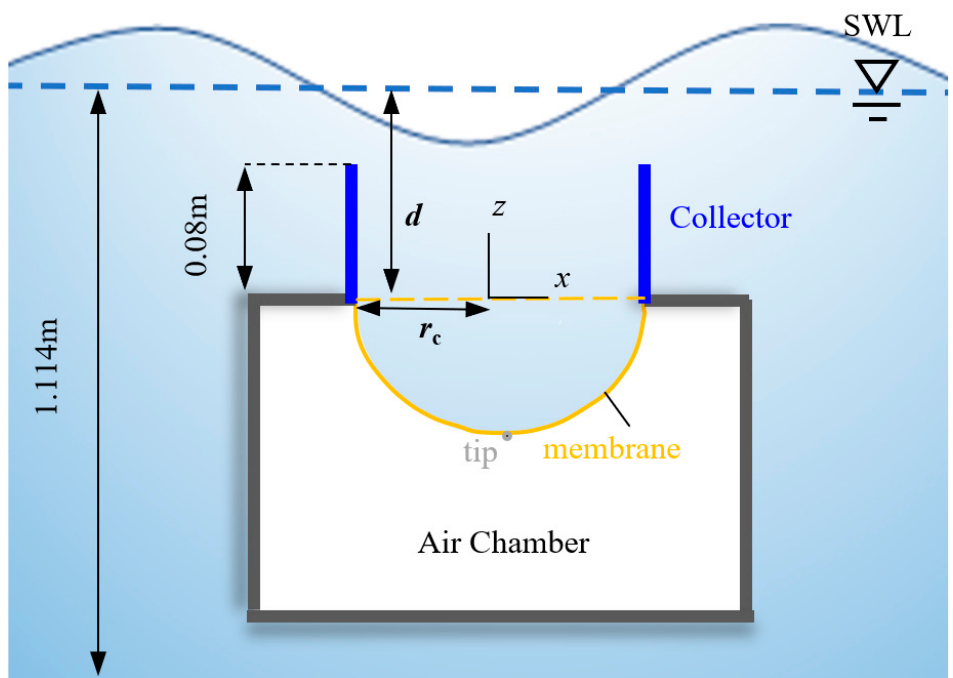
Figure 2. Sketch of the fWEC model. The plates in blue are given the name of the collector to create a water column above the membrane. The yellow solid line denotes the membrane which functions as the PTO. The yellow dashed line denotes the initial position of the membrane (unstretched).